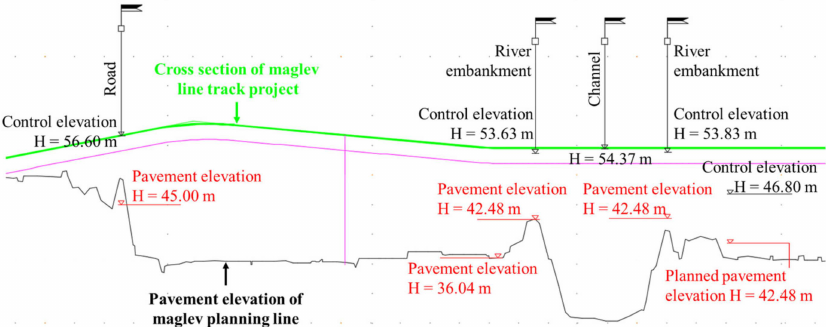
Figure 1. Vertical section of maglev commercial operation line